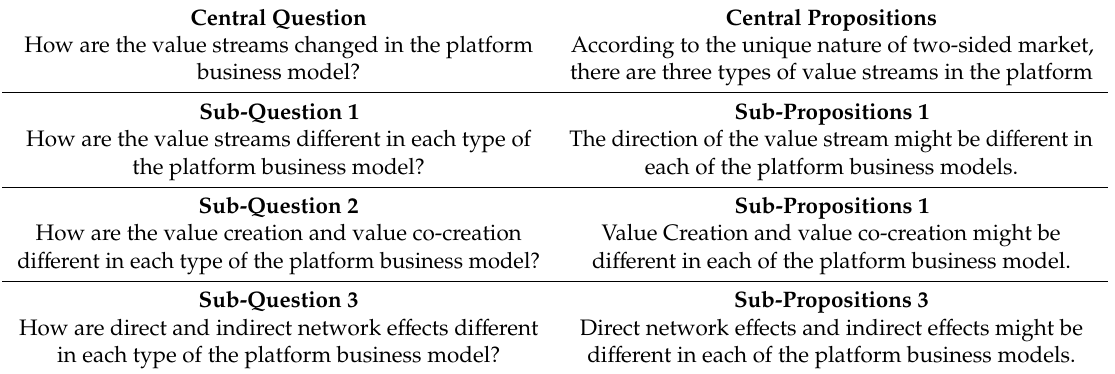
Table 1. Research questions and theoretical propositions.